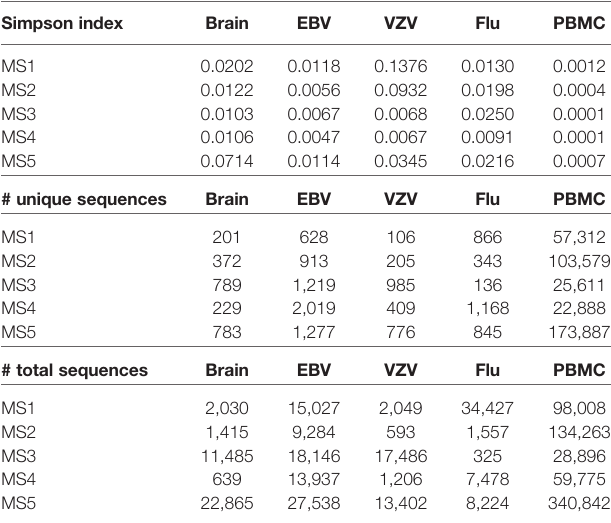
TABLE 4 | Simpson index for TCR b CDR3 amino acid sequences.